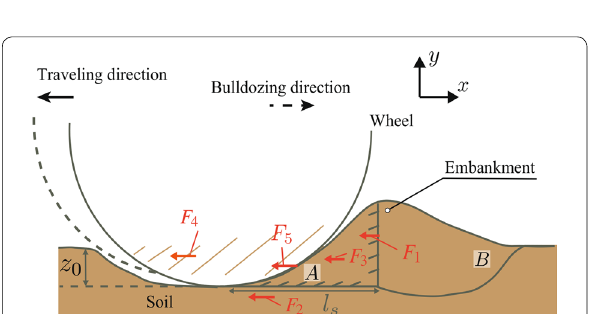
Fig. 4 Relationship between the plate and